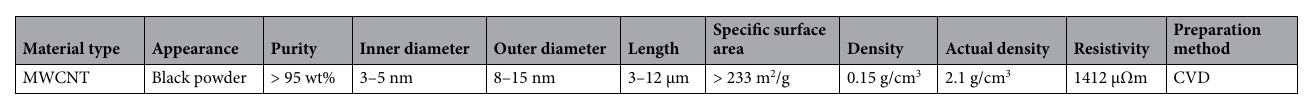
Table 3. Properties of multiwalled carbon nanotubes